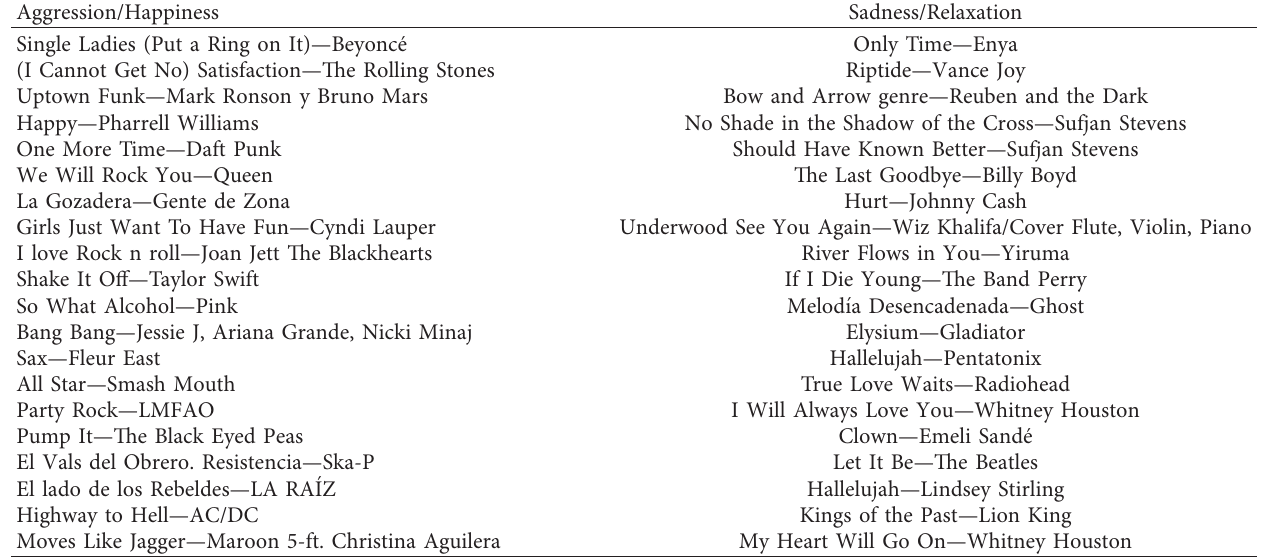
Table 2: Final song